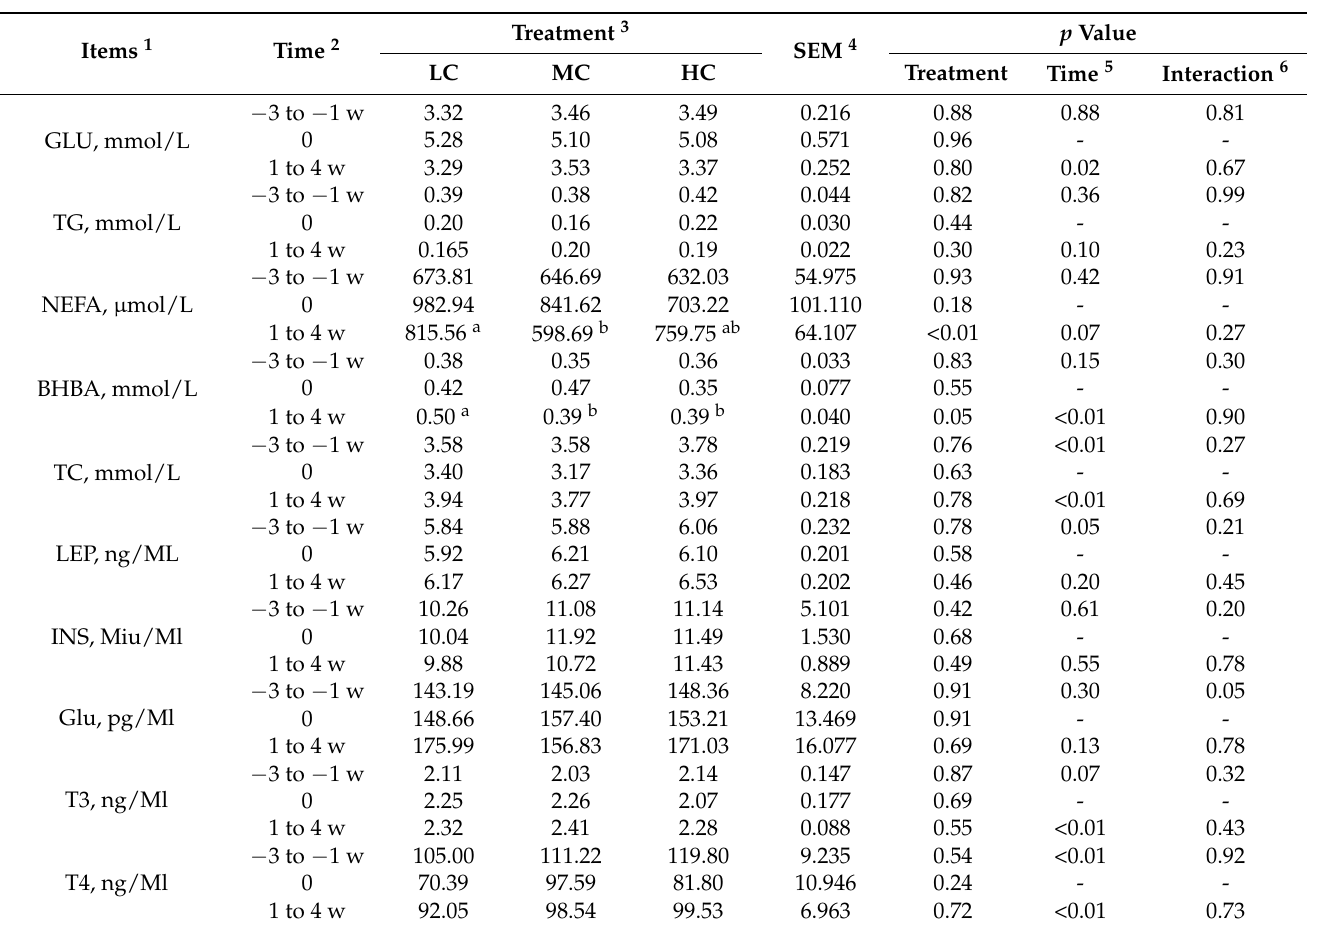
Table 5. Effects of different prenatal concentrate levels on the biochemical plasma indicators of prepartum and postpartum dairy cows.